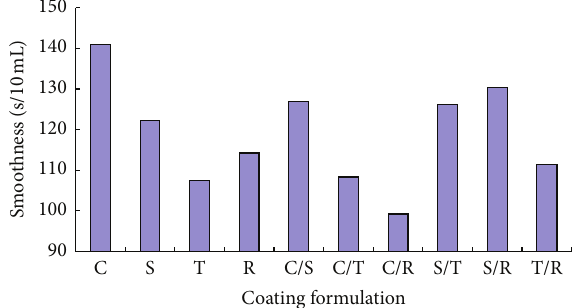
Figure 4: Effects of coating formulations on the smoothness of the resulting coated papers, C: CaCO 3 ; S: SiO 2 ; T: talc; R: sericite, with mixing ratios of